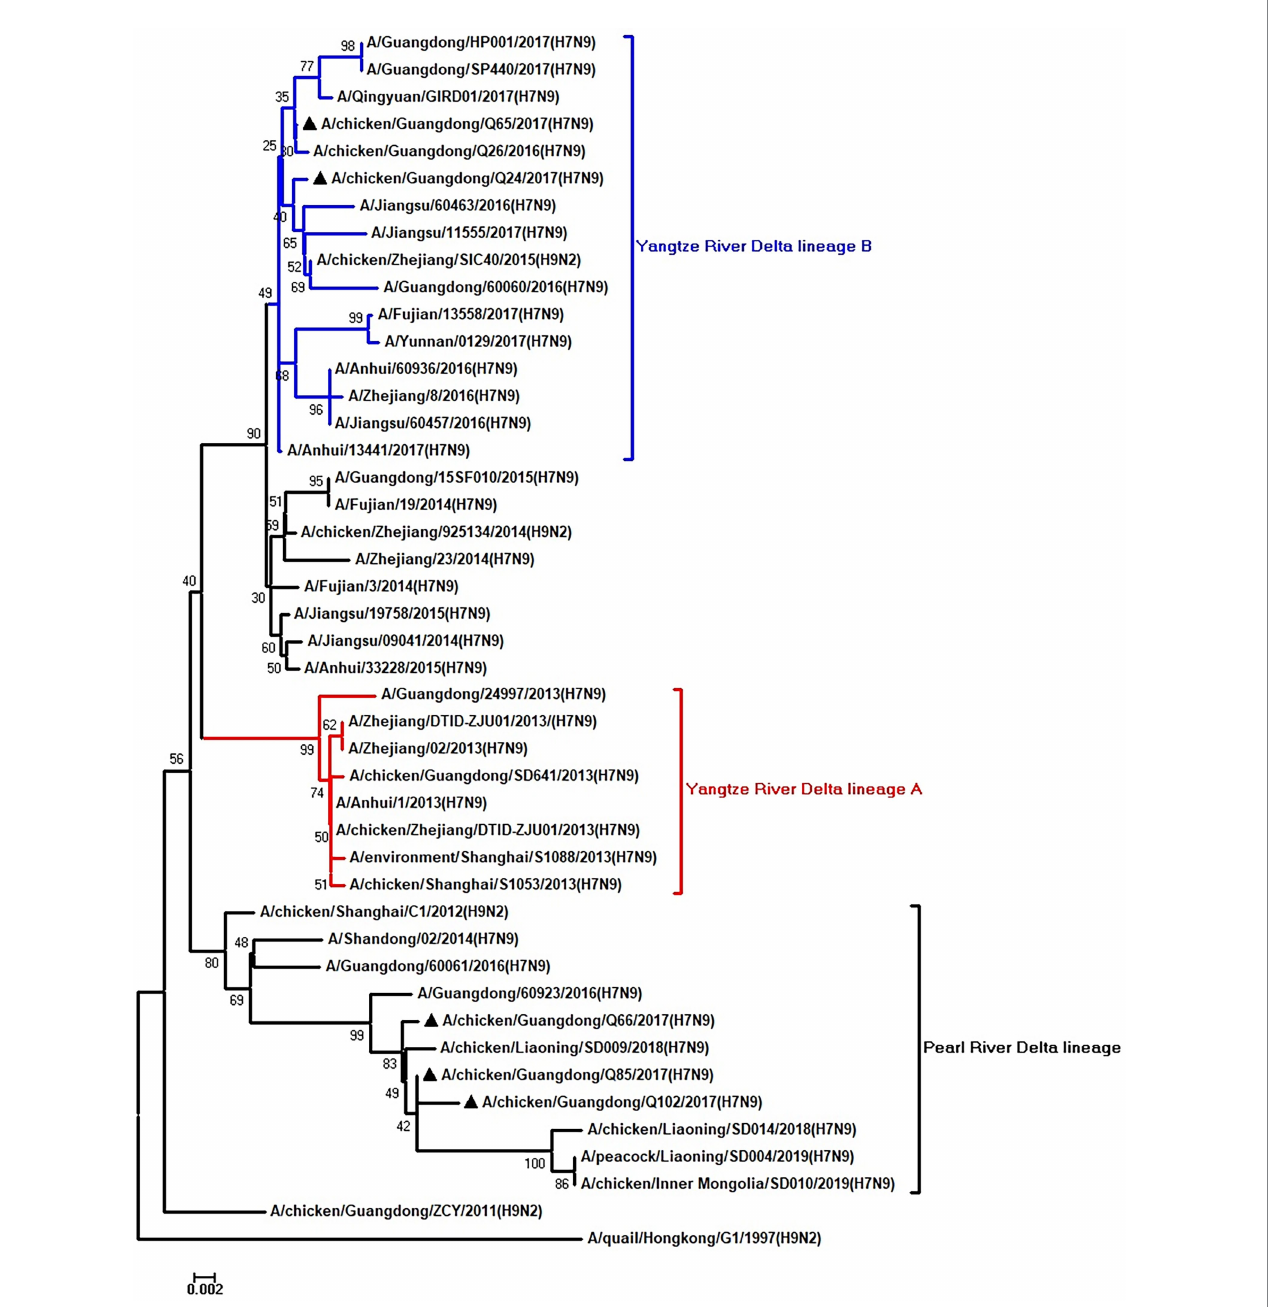
FIGURE 8 Phylogenetic analysis of M. The tree was constructed by using the neighbor joining method with the Maximum Composite Likelihood model and MEGA version 5.2 (www.megasoftware.net/) with 1,000 bootstrap replicates based on the following sequences: M: nt 26–784. Except our five isolates, other virus sequences were downloaded from GenBank. Triangles indicate the viruses characterized in this study. The scale bar indicates the branch length and corresponds to 0.002 estimated amino acid substitutions per